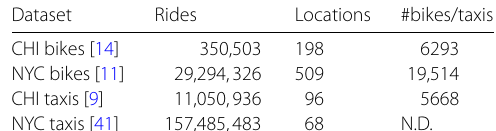
Table 1 Statistics of the four datasets used in our study. For each dataset, we provide the link to download it, the number of rides, the different locations, and the number of bikes/taxis. CHI = Chicago, NYC = New York City. For the NYC taxi dataset, taxi identifiers are not available and we do not know the total number of taxis. All datasets refer to trips in 2018 and